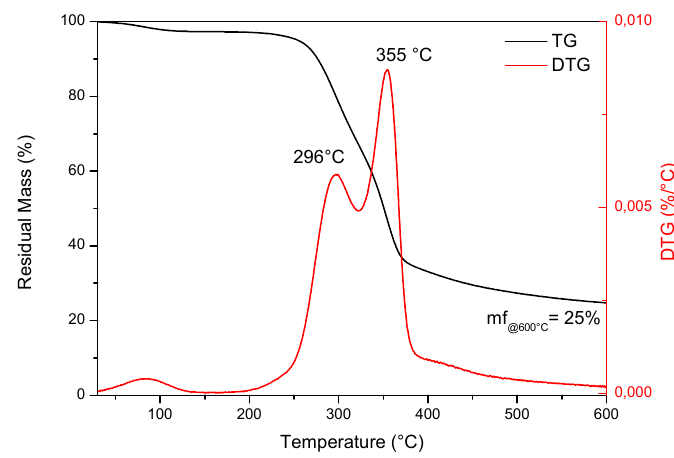
Figure 2. TGA analysis of almond coarse shell powder.